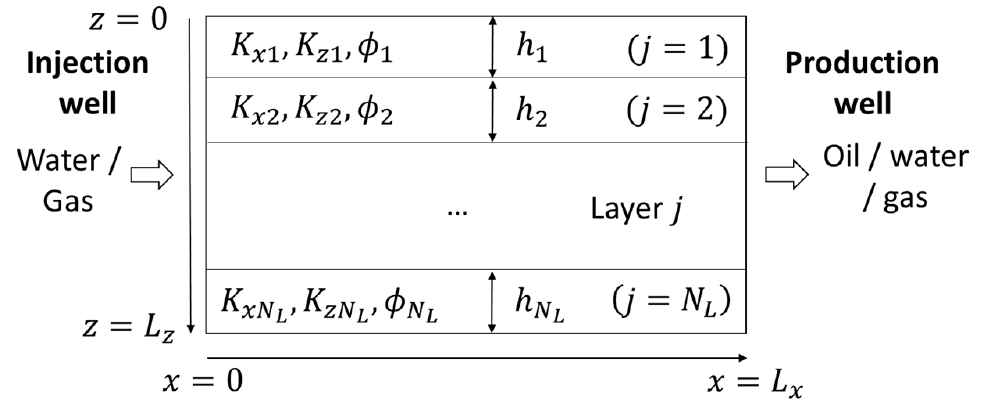
Figure 1. The geometrical configuration of the model (modified from [47]). 𝑥 is the distance from the injector, while 𝑧 is the distance from the top of the reservoir.